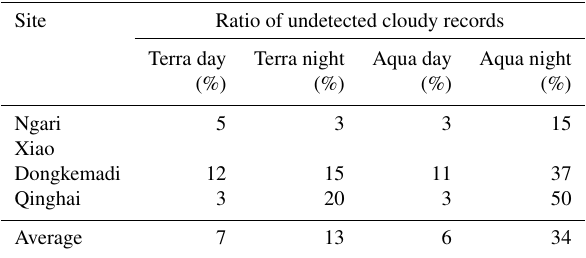
Table 2. Undetected MODIS LST clouds at three